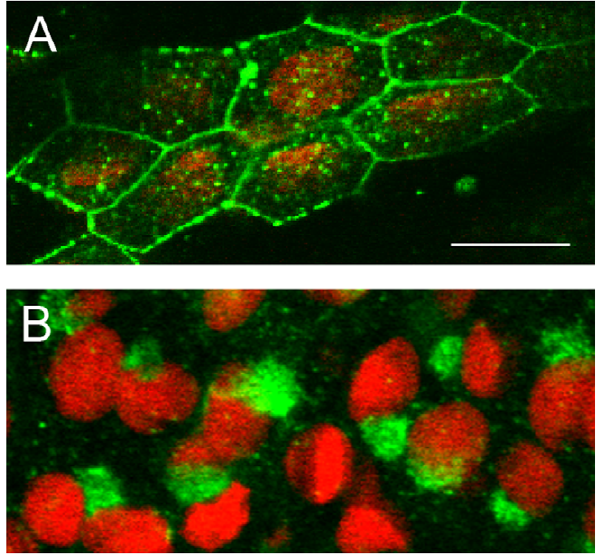
Figure 2. Cx40.8 is localized to different subcellular compart- ments during ontogeny and regeneration. (A) During ontogeny, Cx40.8 immunofluorescence (green) on whole fins counterstained with propidium iodide (red) shows that Cx40.8 locates to the plasma membrane and vesicles. (B) During regeneration, Cx40.8 is intracellular and staining is consistent with the Golgi apparatus.